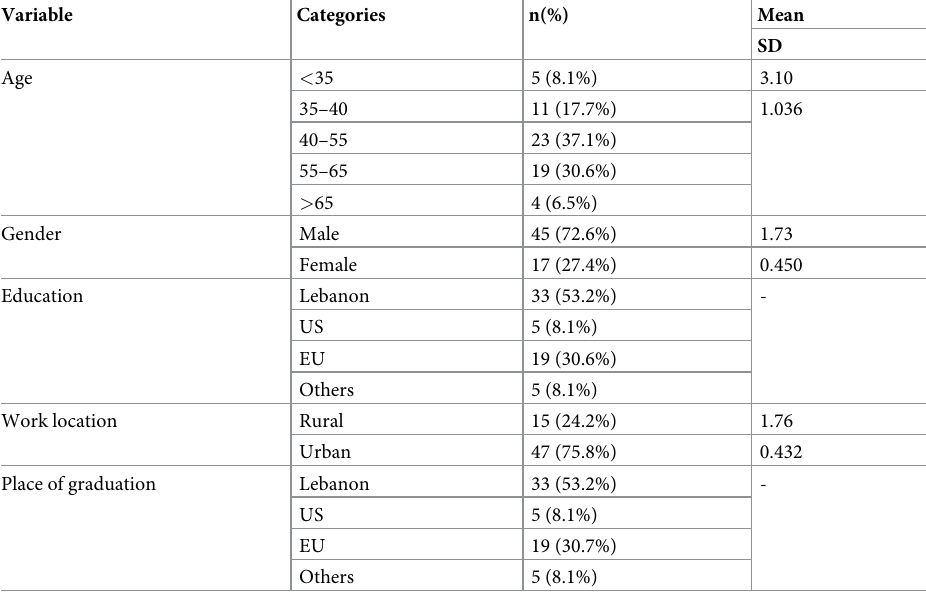
Table 1. Socio-demographic features of the participants, N =